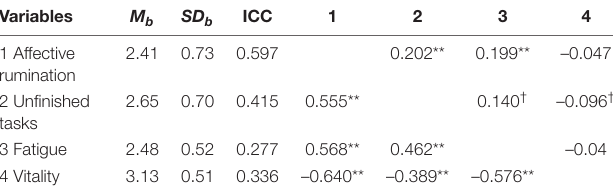
TABLE 1 | Descriptive statistics and correlations of level 1